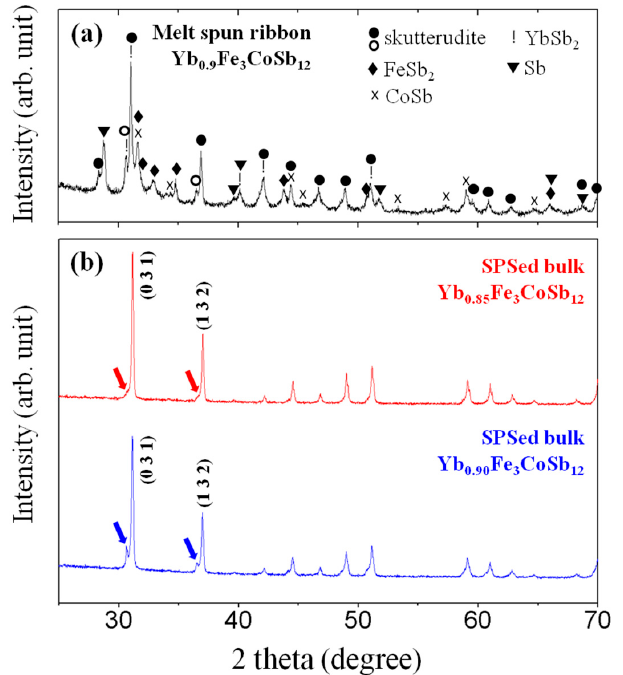
Figure 1. ( a ) X-ray di ff raction (XRD) pattern for the melt spun ribbons of Yb 0.90 Fe 3 CoSb 12 and ( b ) XRD patterns for the SPSed bulks of Yb 0.85 Fe 3 CoSb 12 and Yb 0.90 Fe 3 CoSb 12